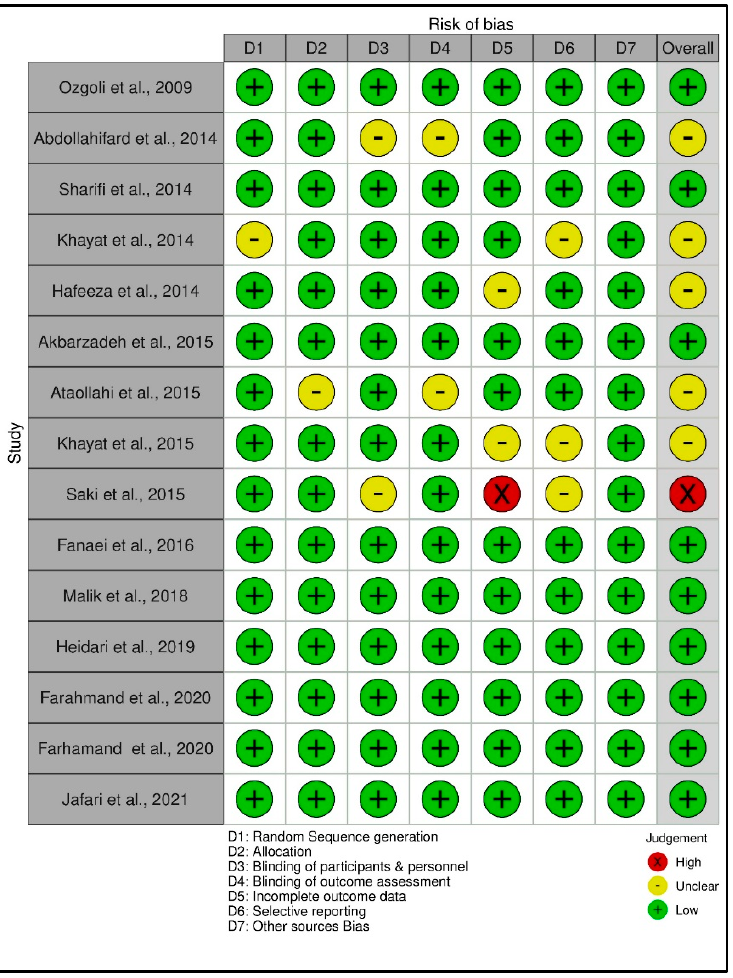
Figure 2. Traffic light plot of randomized controlled trials showing the risk of bias assessment [5,7,43–55]. Bias was measured based on high, low, or unclear individual elements for each do- main using a modified Cochrane Risk of Bias tool for RCTs. The red colour in the traf- fic light plot shows high risk, green colour shows low risk and yellow colour shows un- clear risk of bias. The studies of Ozgoli et al. [7], Sharifi et al. [44], Akbarzadeh et al. [47], Fanaei et al. [51], Malik et al. [52], Heidari et al. [53], Farahmand et al. [54], Farahmand et al. [55], and Jafari et al. [5] all had overall low risk of bias, whereas Saki et al. [50] showed an overall high risk of bias (see Figure 2). The studies of Abdollahifard et al. (2014) [43], Khayat et al. (2014) [45], Hafeeza et al. (2014) [46], Ataollahi et al. (2015) [48], and Khayat et al. (2015) [49], showed an overall risk of bias assessment that was unclear. Further, it was observed that studies conducted from 2016 to 2021 showed a low risk of